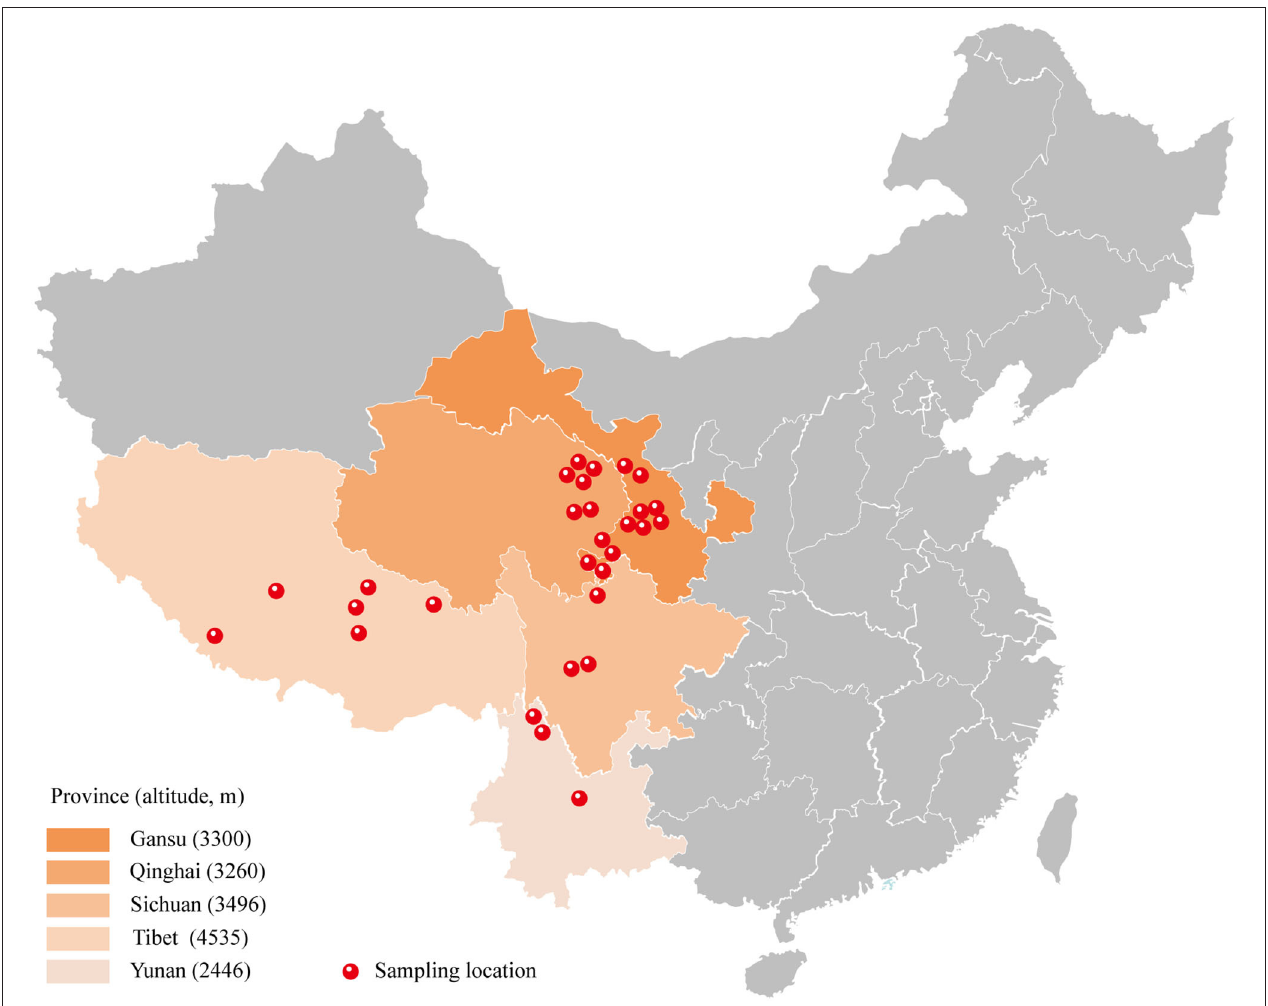
FIGURE 3 | A map showing distinctive sampling locations in different areas. There are five provinces identified with different altitudes: Gansu province, Qinghai province, Sichuan province, Tibet, and Yunnan province.